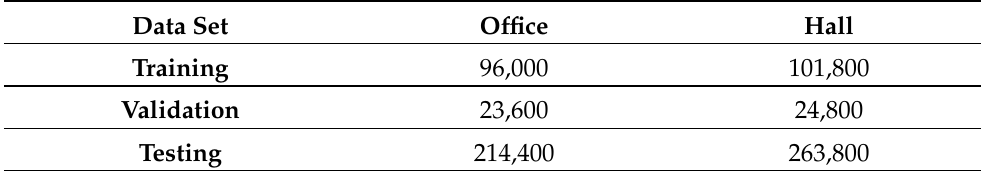
Figure 10. Structure of Deep SVDD. The size of each tensor is depicted in the figure. This structure is used for the proposed decentralized approaches. In the case of centralized approaches, only the size of the input is changed (in the second dimension, 1 is replaced by R ). Table 3. Size of the CSI estimate datasets from the office and the hall